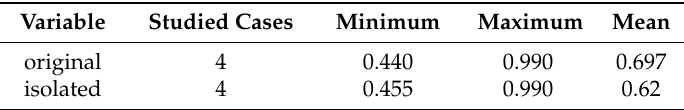
Table 5. Performance